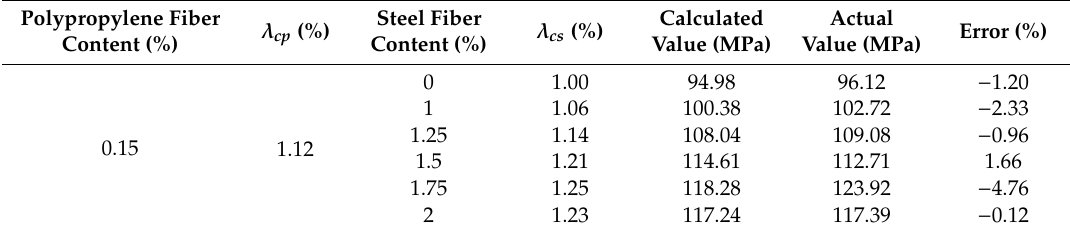
Table 15. Compressive strength of hybrid polypropylene-steel fiber RPC at 28